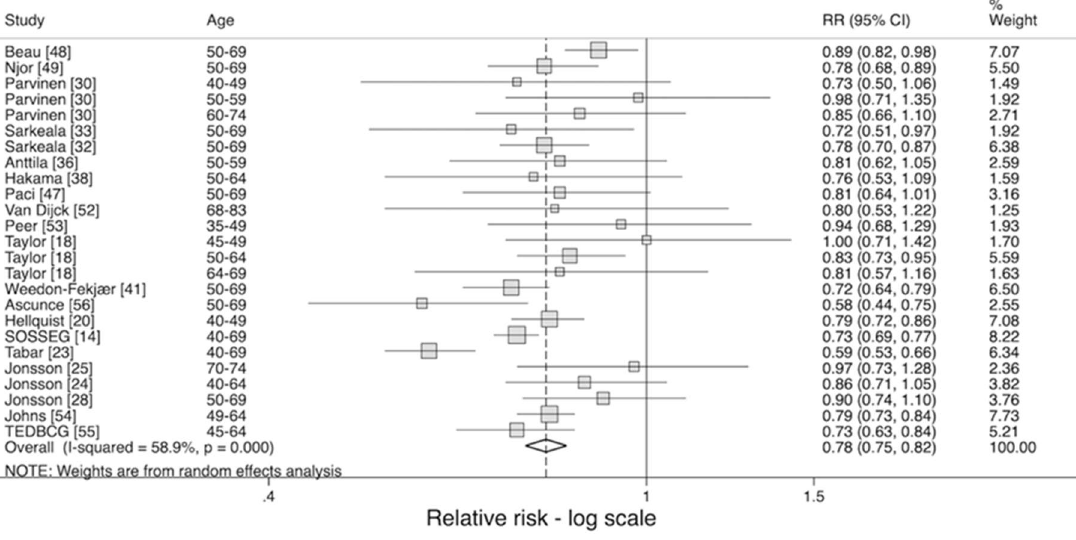
ff ect of invitation on risk of breast cancer mortality [14,18,20,23–25,28,30,32,33,36,38,41,47–